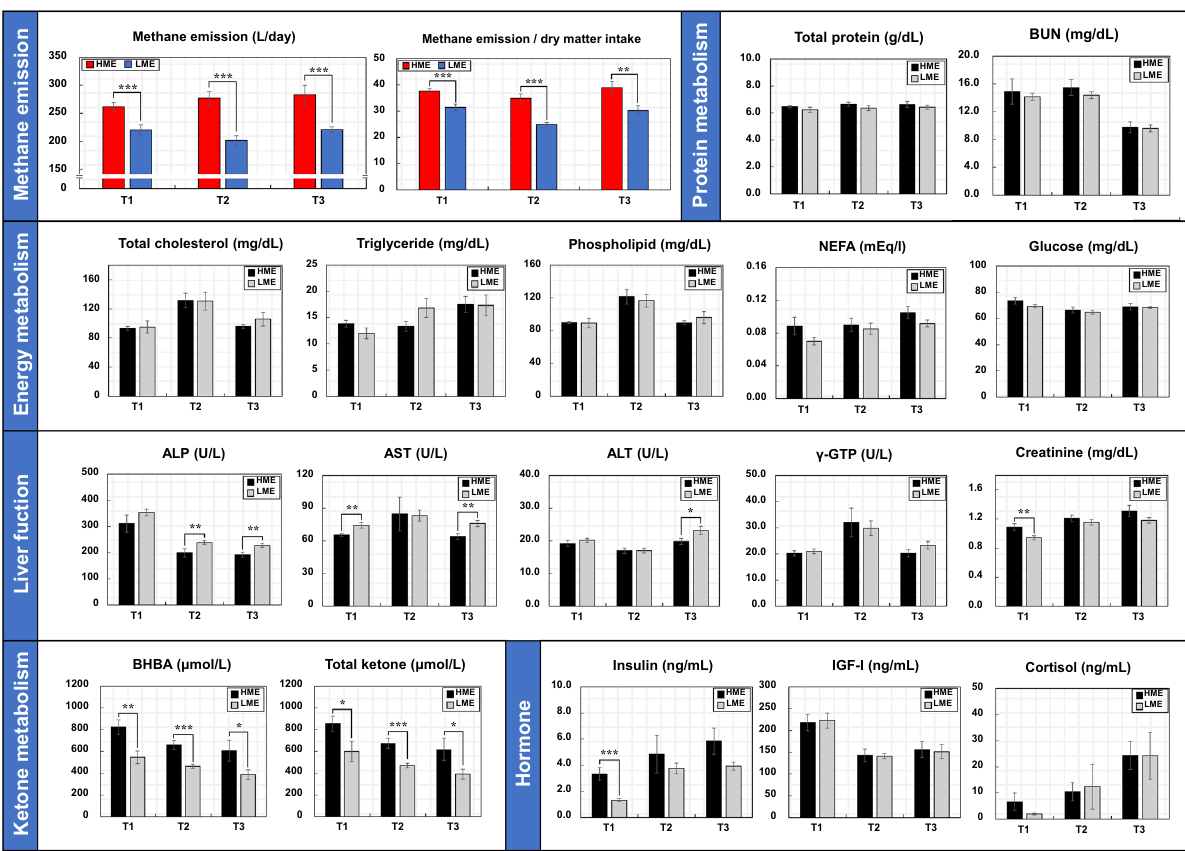
Figure 1. Comparisons of methane emissions and blood metabolite levels in HME vs LME cattle during the fattening period. T1: early fattening phases (13 months of age), T2: middle fattening phases (20 months of age), T3: late fattening phases (28 months of age). HME: group of high methane emission cattle (n = 6), LME: group of low methane emission cattle (n = 6). BUN: blood urea nitrogen, NEFA: non-esterified fatty acid, ALP: alkaline phosphatase, AST: aspartate aminotransferase, ALT: alanine aminotransferase, γ-GTP: gamma(γ)- glutamyl transferase, BHBA: β-hydroxybutyric acid, IGF-I: insulin-like growth factor 1. Data are presented as mean ± SEM. * p < 0.1, ** p < 0.05, and *** p <